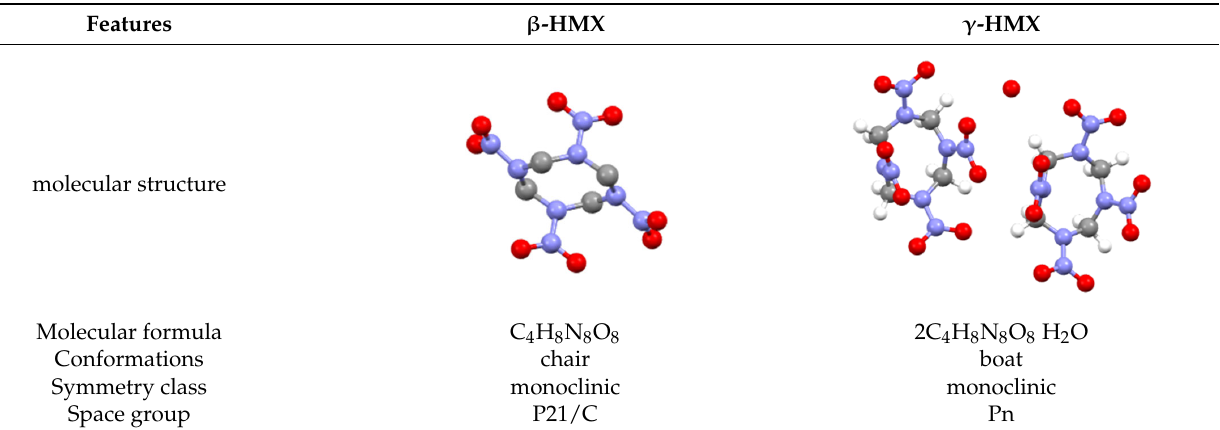
Table 1. Some distinguishing features of β -HMX and γ -HMX.